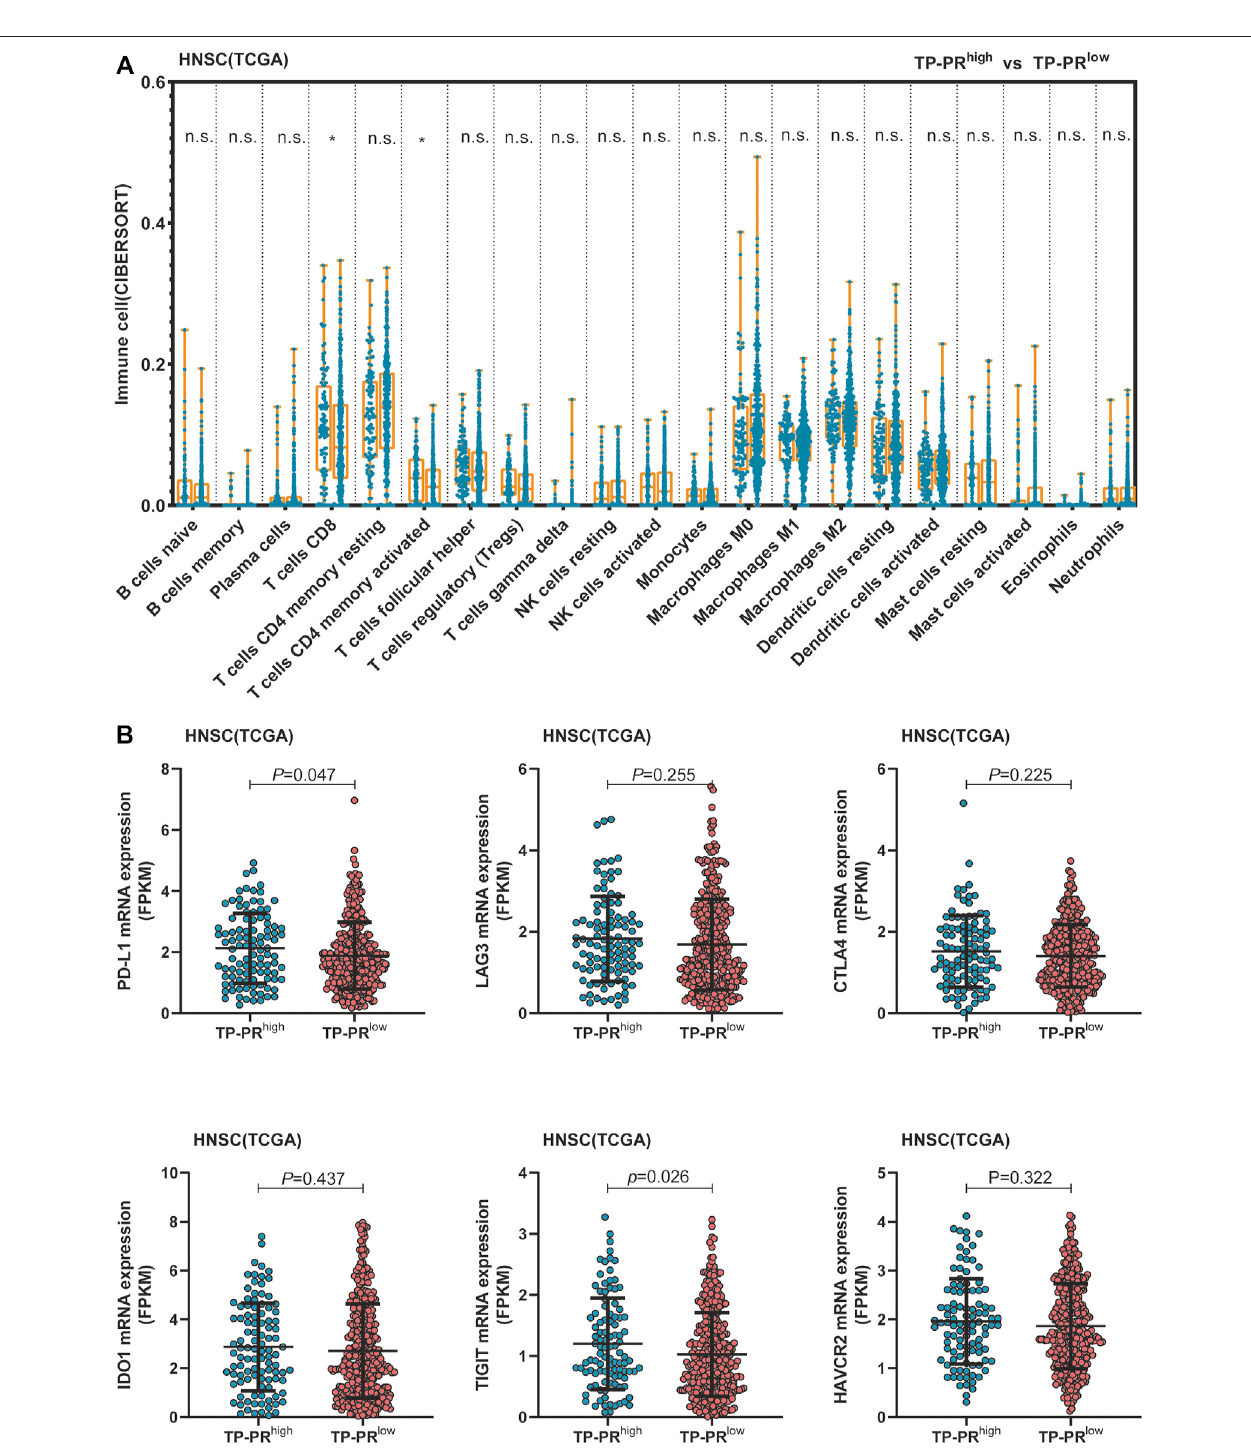
FIGURE 7 | (A) Comparison of immune cell in fi ltration between the high and low TP-PR HNSCC patients in TCGA cohort. (B) mRNA expression of some immunotherapy-related targets in high TP-PR vs. low TP-PR HNSCC patients. HNSCC, head and neck squamous cell carcinoma; TCGA, The Cancer Genome Atlas.